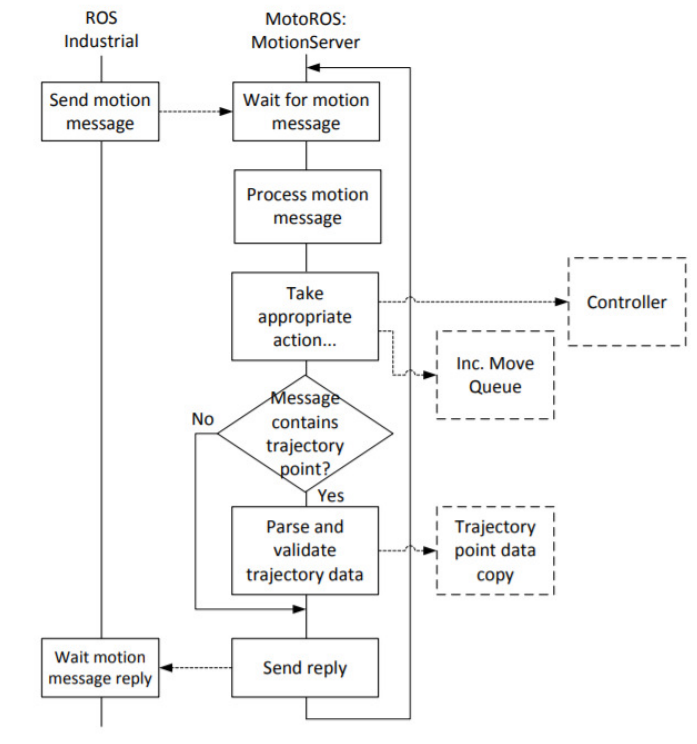
Figure 4. Motion Server Task [35].